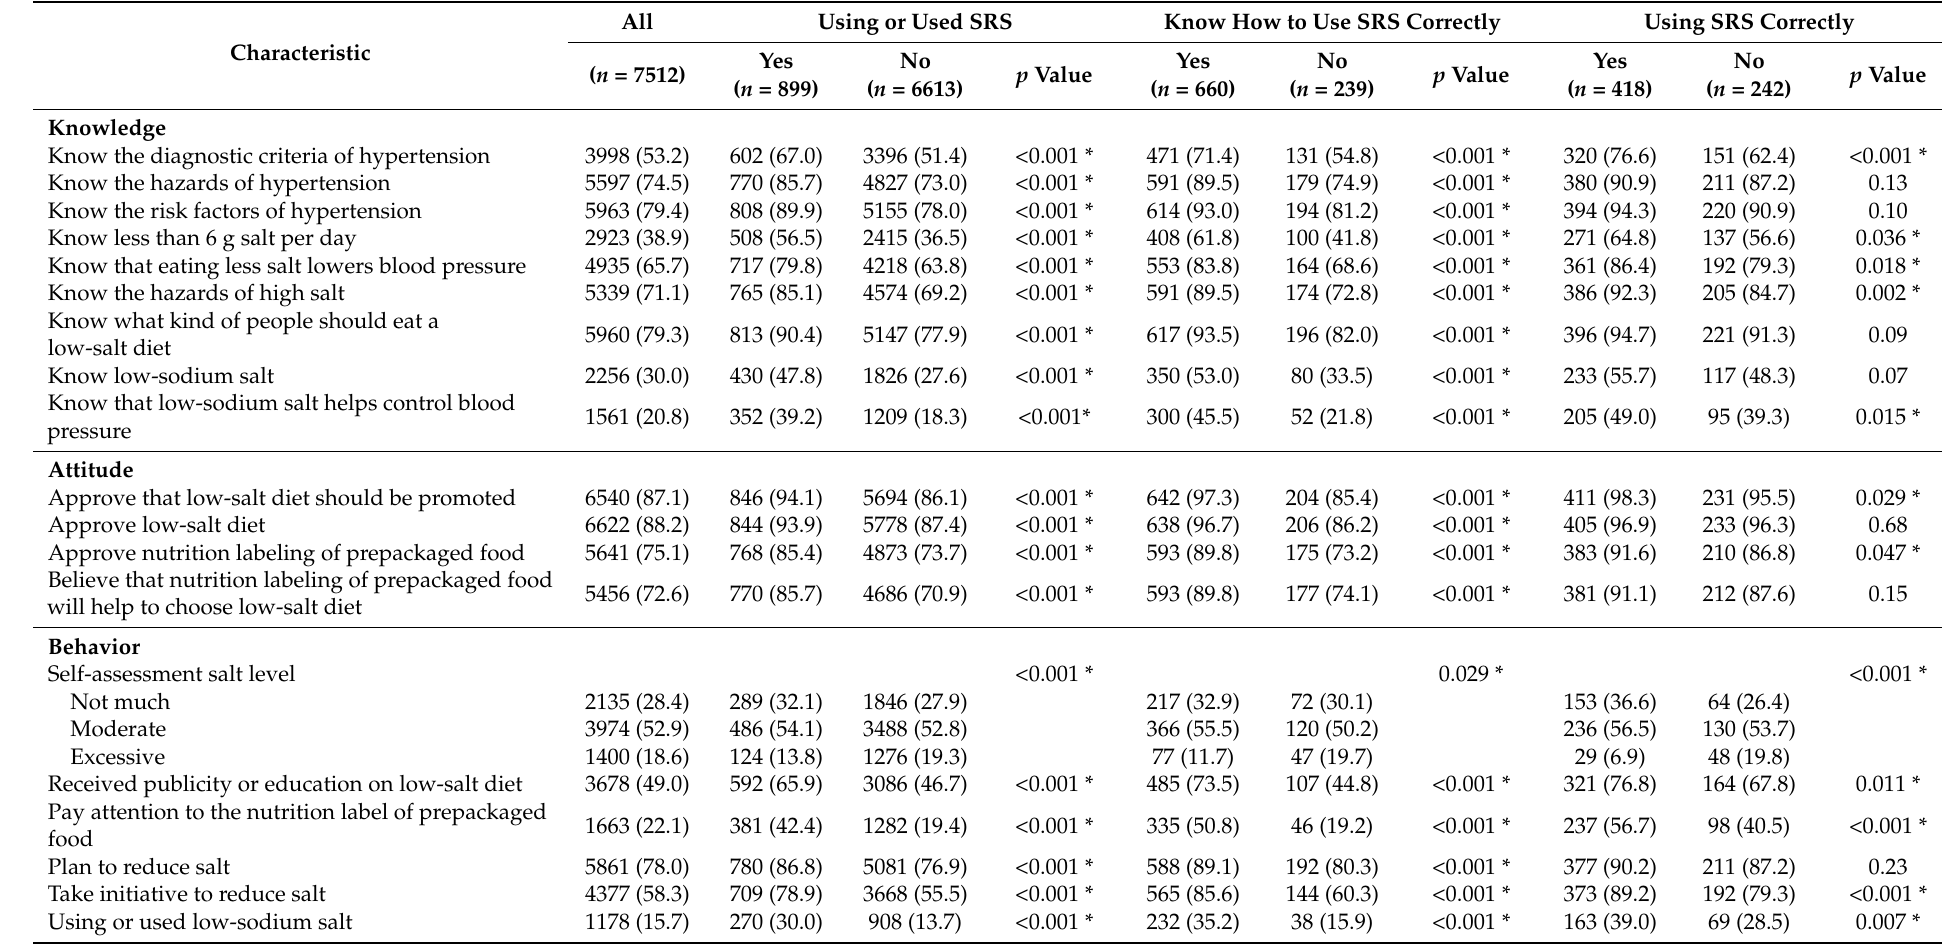
Table 3. Characteristics of knowledge, attitude, and behavior of 7512 participants by salt-restriction spoon